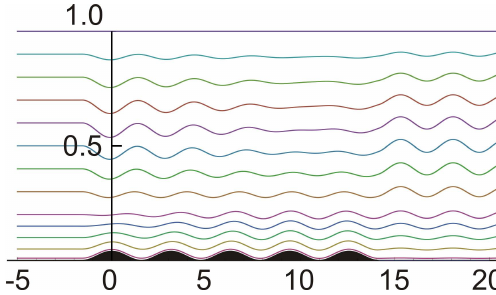
Fig. 2. Lee wave interference with shadow zone over the barrier.